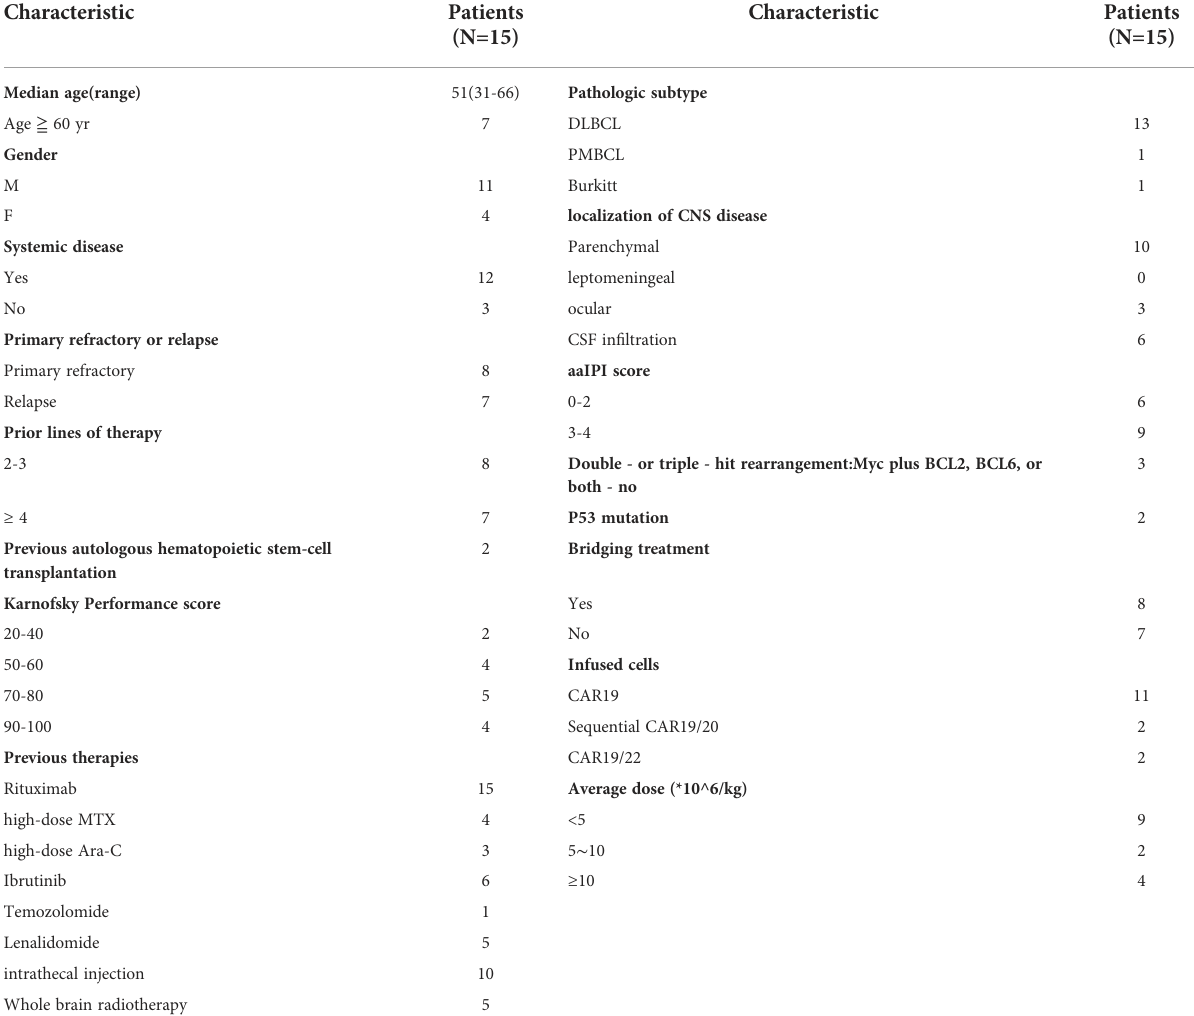
TABLE 1 Clinical Characteristics at